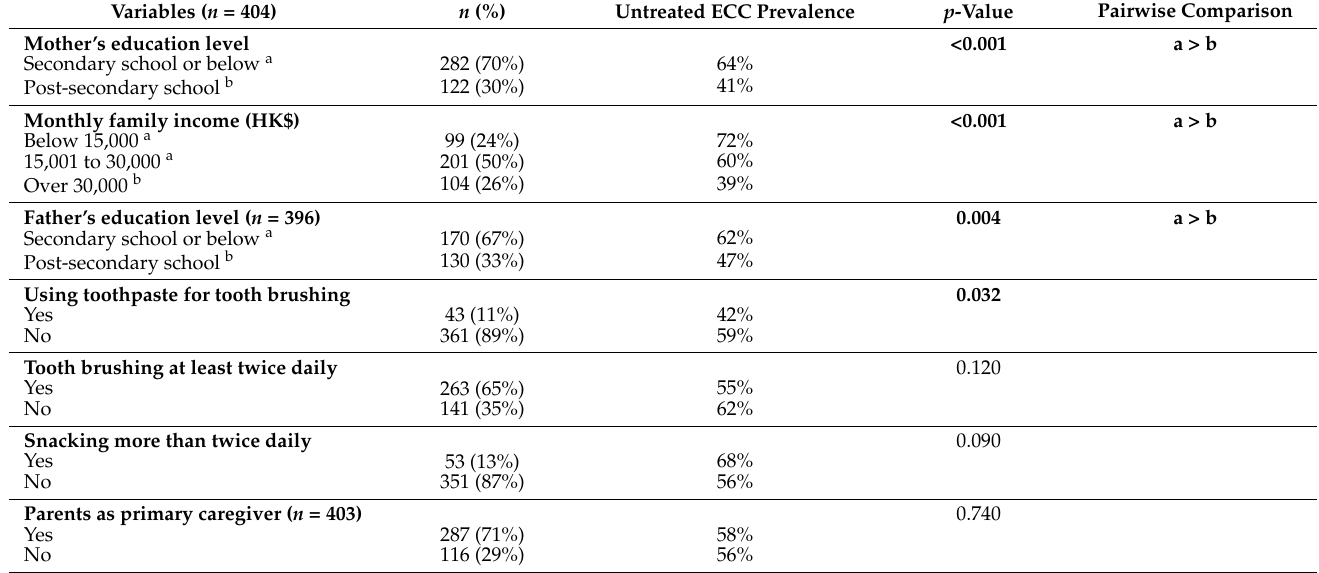
Table 2. Untreated ECC prevalence (dt > 0) and independent